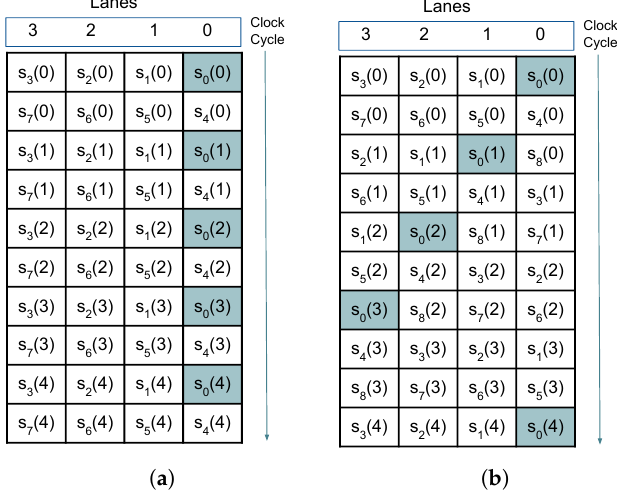
Figure 3. Sample placement timing diagram, ( a ) N z = 8, N p = 4, ( b ) N z = 9, N p = 4.